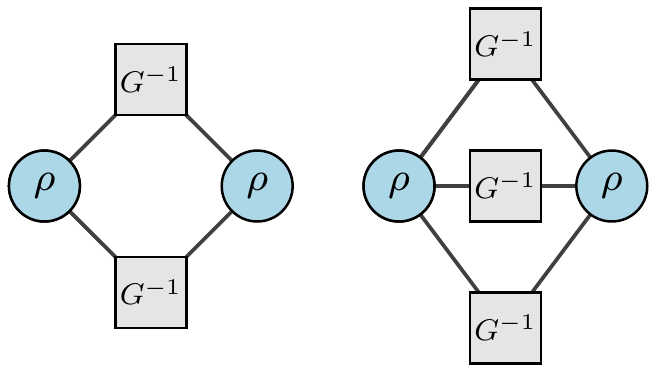
Figure 1 . On the left: matrix product representation of the genus one conformal block in eq. (3.19). On the right: matrix product representation of the genus two conformal block in eq.